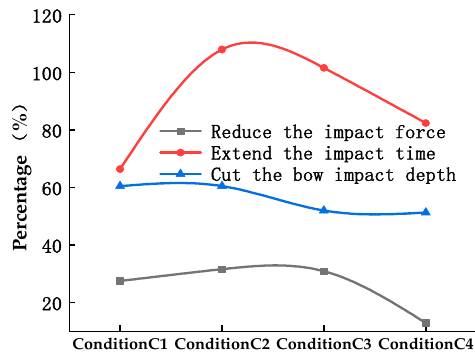
Figure 28. Collision avoidance performance of device.